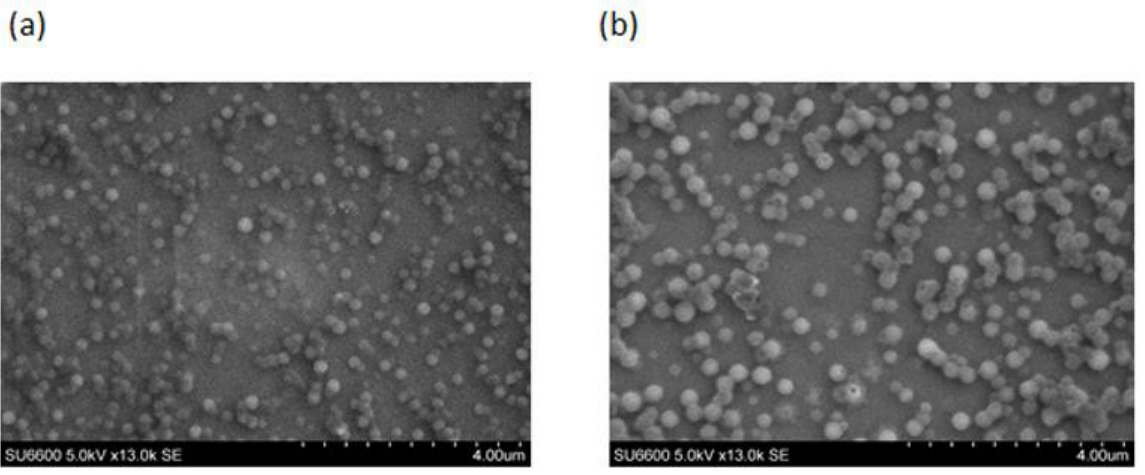
Figure 4: SEM images of (a) IPP-CZ NPs and (b) LKP-CZ NPs Figure 4. SEM images of ( a ) IPP-CZ NP and ( b ) LKP-CZ NP. Table 3. Percentage of ACE inhibition of free IPP/LKP, uncoated NP and CZ NP at peptide